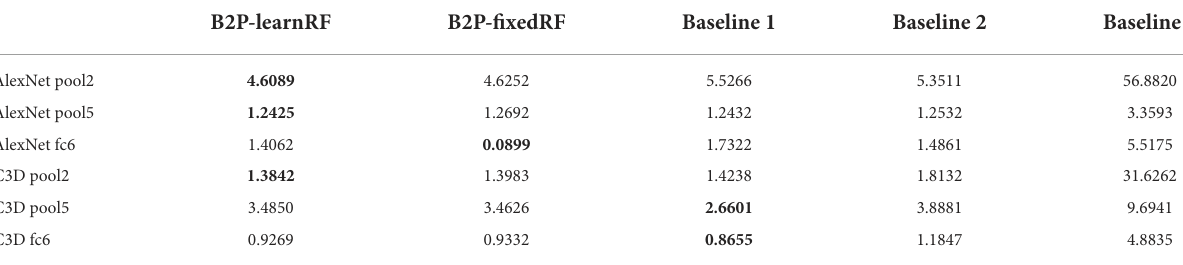
TABLE 2 Baseline experiment distance values